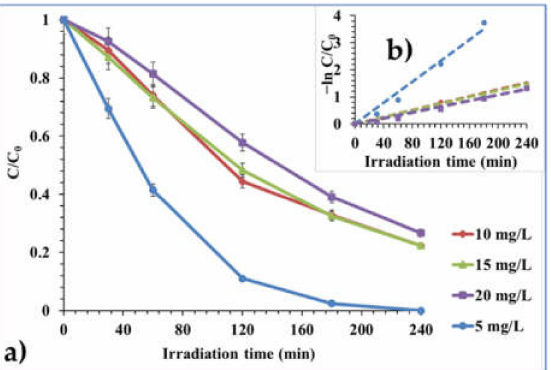
Figure 11. ( a ) Effect of initial CBZ concentration on the photocatalytic degradation performance of 1 g/L Mo/SynTiO 2 under natural (unmodified) pH 5.84, and 365 nm irradiation, and ( b ) their corresponding photocatalytic degradation rate constant